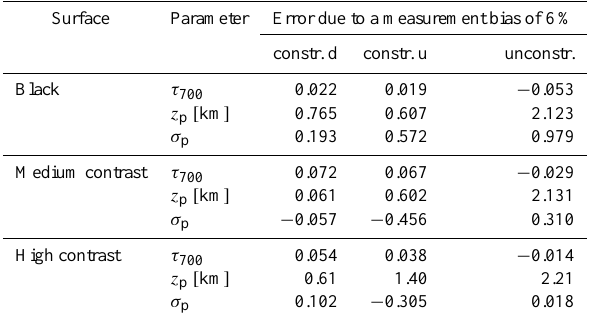
Table 6. Errors caused in the retrieval of retrieved parameters due to a measurement bias of 6% (arbitrarily